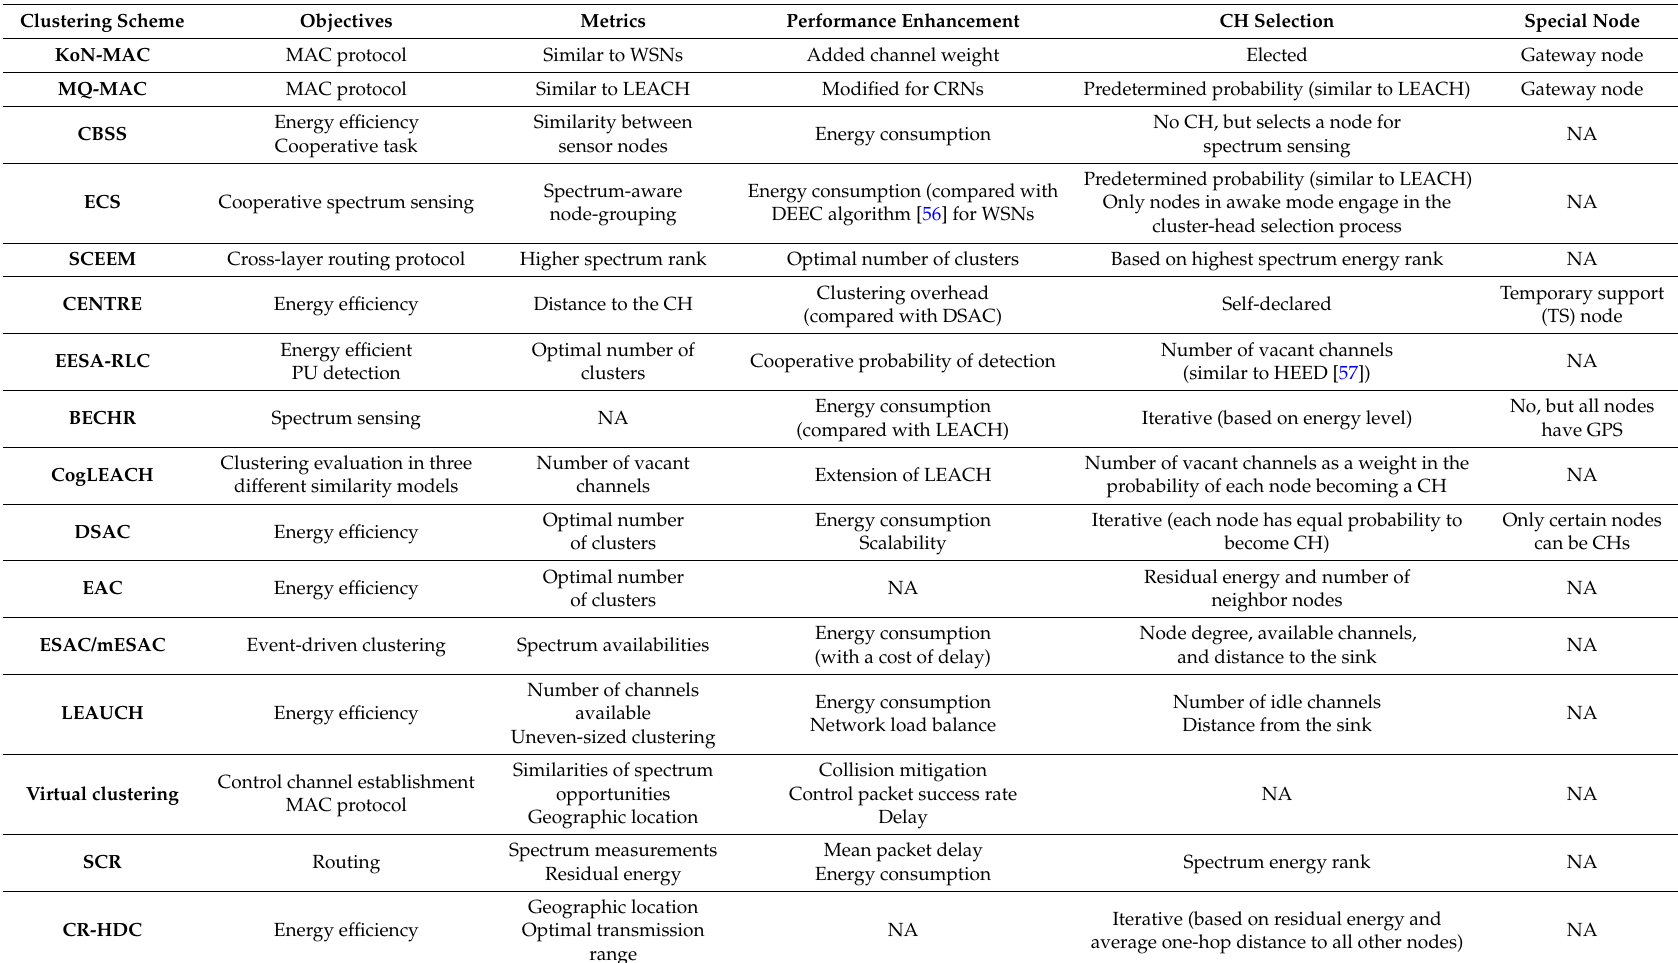
Table 2. Comparison of the existing clustering schemes for